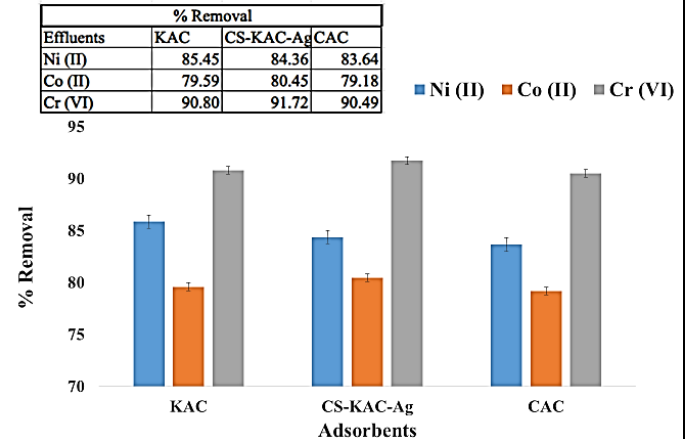
Figure 9. Removal % of Ni (II), Co (II), and Cr (VI) using (KAC), commercial activated carbon Calgon (CAC), and CS-KAC-Ag.